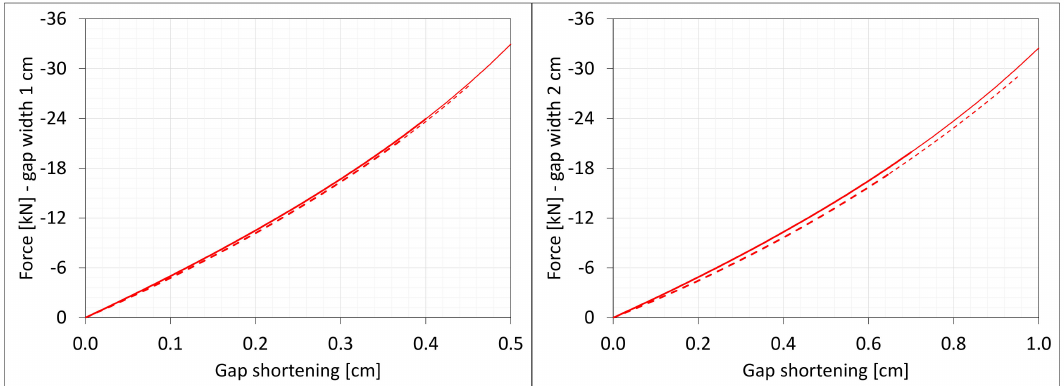
Figure 22. Equilibrium paths for excitation force N z The width of the gap is equal to 1.0 cm, left graphic, and 2.0 cm, right. Plane strain models, solid lines; and 3D models, dashed lines (curves from Figure 7). Parts of charts with non-physical de-formations are displayed with thin